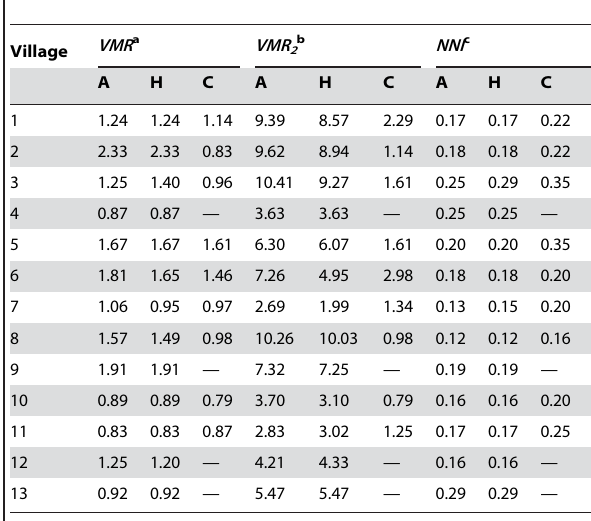
Table 4. Clustering indices for all pig-rearing households (A), those with healthy pigs (H), and those with cysticercotic (C)